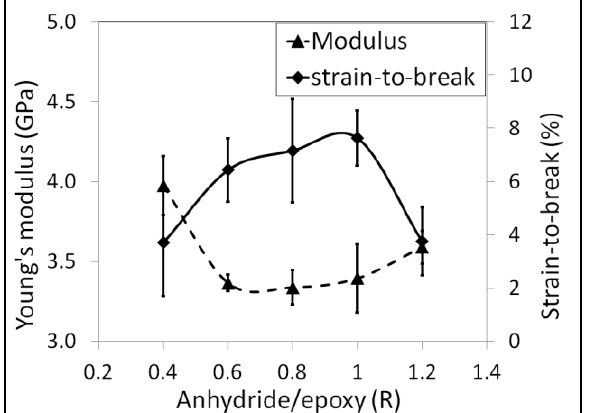
Figure 5. Modulus and strain-to-break of the neat epoxy with different anhydride/resin